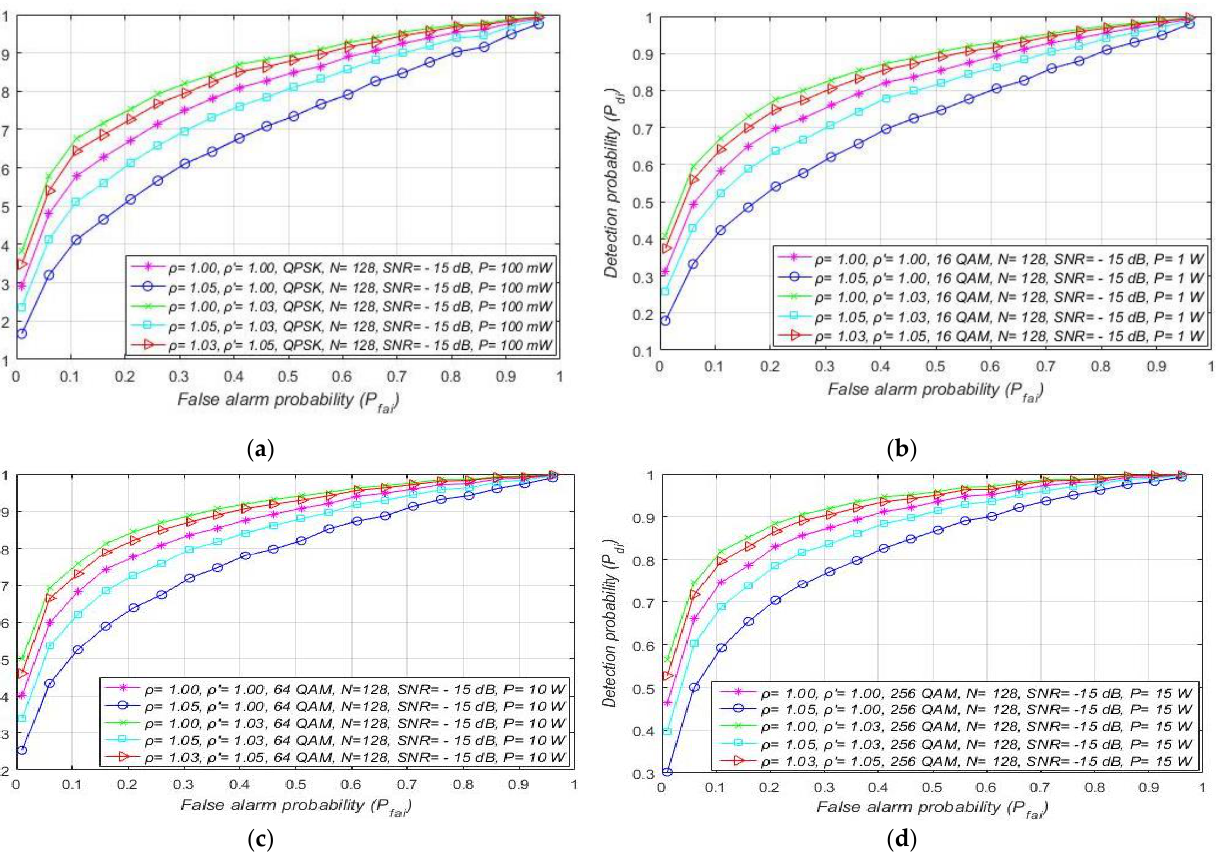
Figure 7. Interdependence between detection and false alarm probabilities for ED of signals in combined RA and MA system under versatile combination of NU and DT factors and PU transmission using: ( a ) QPSK modulation at Tx power of 0.1 W; ( b ) 16 QAM modulation at Tx power of 1 W; ( c ) 64 QAM modulation at Tx power of 10 W and ( d ) 256 QAM modulation at Tx power of 15 W.